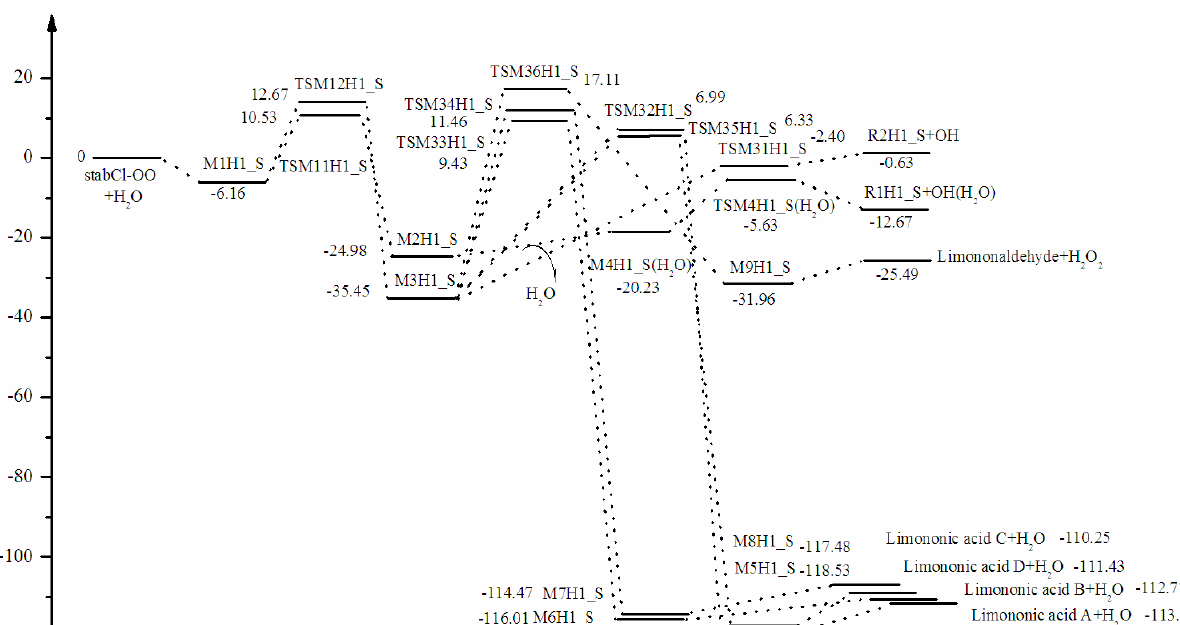
O reaction coordinates: relative energies of the stationary points Figure 4. stabCI-OO + H 2 located on the separate stabCI-OO and H O ground-state potential energy surface. The 2 energy values are given in kcal mol − 1 and were calculated using CCSD(T)/6-31G(d) + CF//B3LYP/6-31G(d,p)